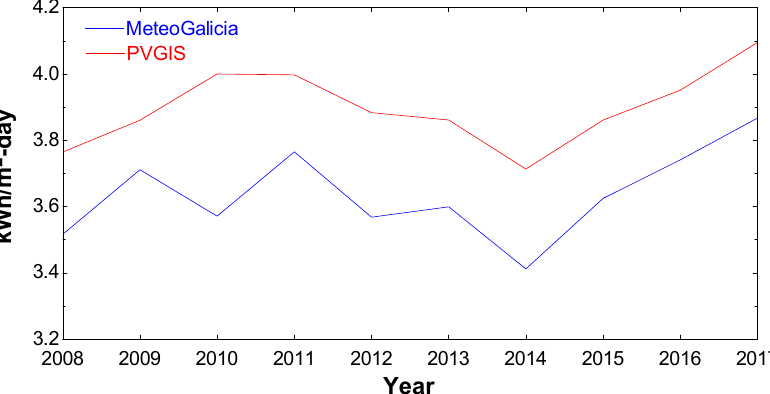
Figure 4. Evolution of the monthly mean GHR index: PVGIS vs. MeteoGalicia (Santiago EOAS, 2008–2017).